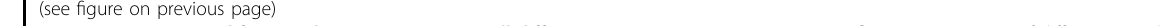
Fig. 2 ESR1 is required for muscle stem/progenitor cell differentiation. a Representative immuno fl uorescent staining of differentiating human muscle stem/progenitor cells treated with DMSO, ESR1 agonist PPT, or ESR1 antagonist MPP for six days. Red indicated MyHC; Blue indicated DAPI staining of nuclei. The merged images were shown. Scale bars: 100 μ m. b Statistical analysis of average diameters of myotubes. Error bars indicated standard deviation ( n = 5). *** P < 0.001. c Statistical analysis of differentiation ef fi ciency. Error bars indicated standard deviation ( n = 5). *** P < 0.001. d Expression levels of differentiation markers. Total RNA was extracted from differentiating cells treated by DMSO, ESR1 agonist PPT, or ESR1 antagonist MPP for six days followed by RT-qPCR analysis. Error bars indicated standard deviation ( n = 3). *** P < 0.001, ** P < 0.01. e Gene expression level of Esr1 in Esr1 KO muscle stem cells. The primary muscle stem cells were isolated from Pax7-CreERT2; Esr1 f/f mice after tamoxifen induction. Esr1 expression level was next analyzed by RT-qPCR. Error bars indicated standard deviation ( n = 3). ** P < 0.01. f Immunoblotting of Esr1 in Esr1 KO muscle stem cells. The primary muscle stem cells were isolated from Pax7-CreERT2; Esr1 f/f mice after tamoxifen induction. GAPDH was served as control. g Pictures of 8-weeek-old Esr1 f/f and Esr1 KO female mice. Scale bar: 1 cm. h Statistical analysis of the body weight of Esr1 f/f and Esr1 KO mice. Mice were treated with vehicle ( Esr1 f/f ) or tamoxifen ( Esr1 KO) every other day from 2 weeks old to 3 weeks old. Five female mice were weighted at 3 weeks old and 8 weeks old in each group. Error bars indicated standard deviation ( n = 5). ** P < 0.01; ns indicated no signi fi cant changes. i Representative immuno fl uorescent staining of cryosection of para-spinal muscle derived from Esr1 f/f and Esr1 KO mice, respectively. Green indicated laminin; Blue indicated DAPI staining of nuclei. The merged images were shown. Scale bars: 100 μ m. j Statistical analysis of cross-sectional area of para-spinal muscle derived from Esr1 f/f and Esr1 KO mice, respectively. At least 500 fi bers were analyzed for each sample. Error bars indicated standard deviation ( n = 4). ** P < 0.01. k Representative immuno fl uorescent staining of myotubes differentiated from muscle stem cells isolated from Esr1 f/f and Esr1 KO mice, respectively. Red indicated MyHC; Blue indicated DAPI staining of nuclei. The merged images were shown. Scale bars: 100 μ m. l Statistical analysis of the average diameters of myotubes differentiated from Esr1 f/f or Esr1 KO muscle stem cells. Error bars indicated standard deviation ( n = 5). *** P < 0.001. m Fusion index of myotubes differentiated from Esr1 f/f or Esr1 KO muscle stem cells. Error bars indicated standard deviation ( n = 5). *** P < 0.001; ns indicated no signi fi cant changes. n Expression levels of differentiation markers in myotubes differentiated from Esr1 f/f or Esr1 KO muscle stem cells. Error bars indicated standard deviation ( n = 3). ** P < 0.01; *** P <